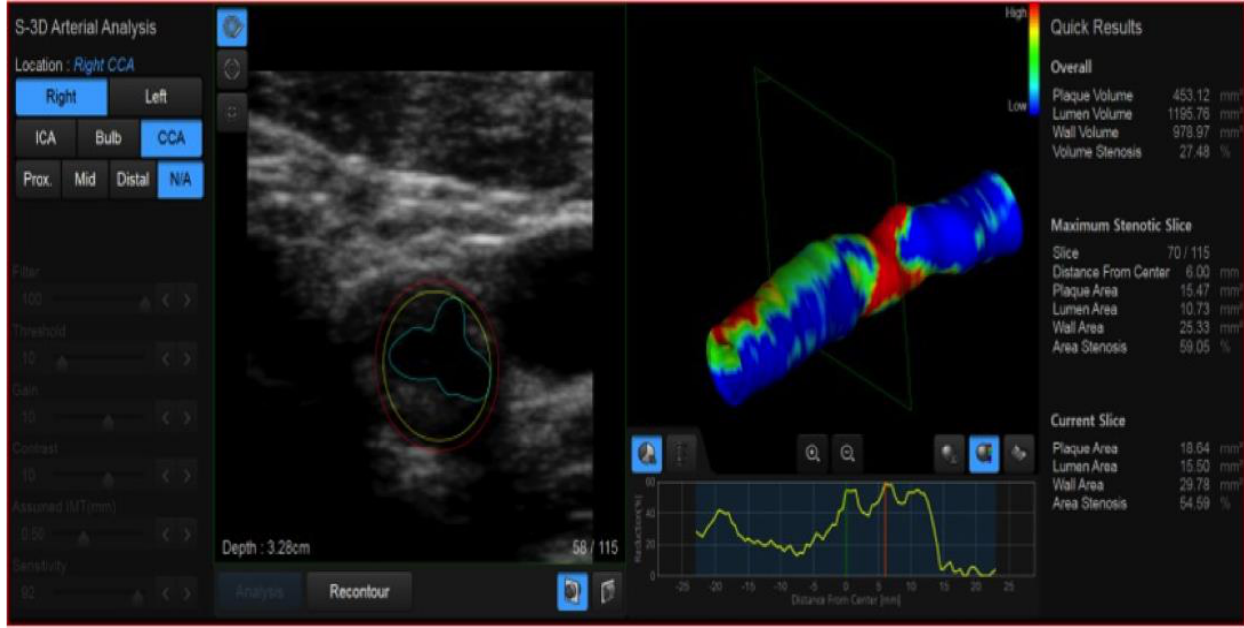
Figure 7. 3D-US carotid stenosis evaluation. Table 3. V-flow and 3D-US advantages and disadvantages for detection of carotid stenosis. V-flow 3D-US